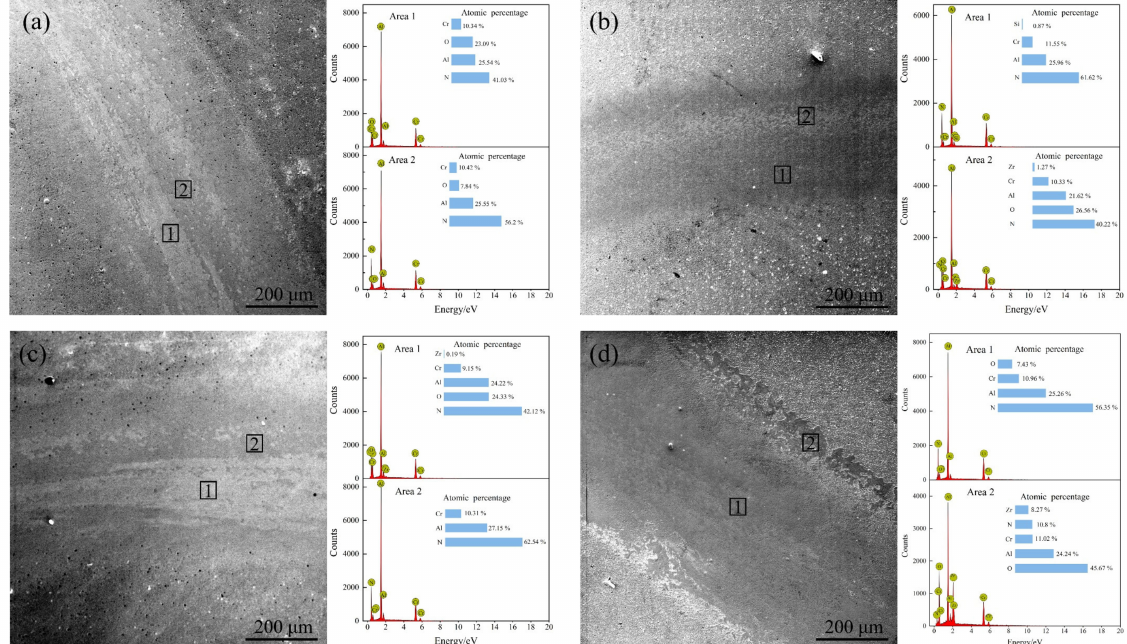
Figure 11. Abrasion morphology of the coatings at different bias voltages: ( a ) − 60 V; ( b ) − 80 V; ( c ) − 100 V; ( d ) − 120